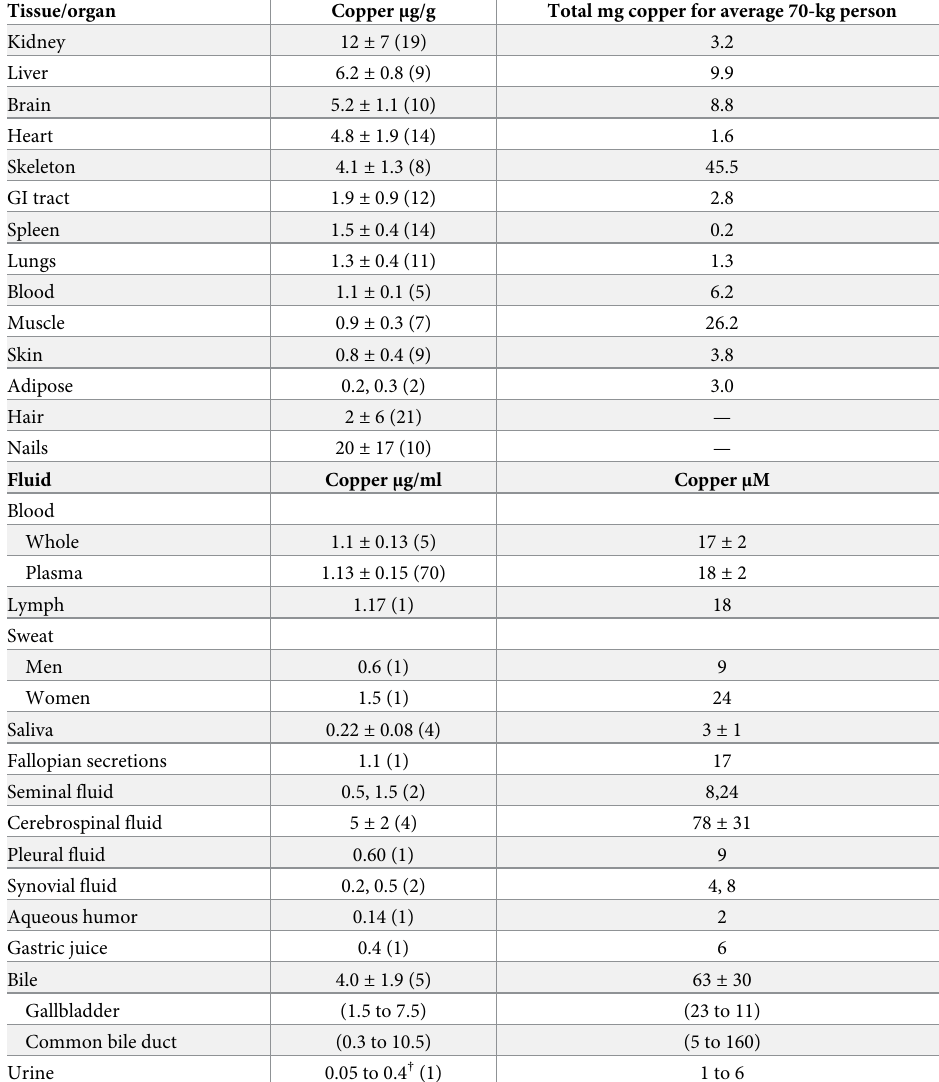
Table 1. Copper content of human organs, tissues, and bodily fluids.